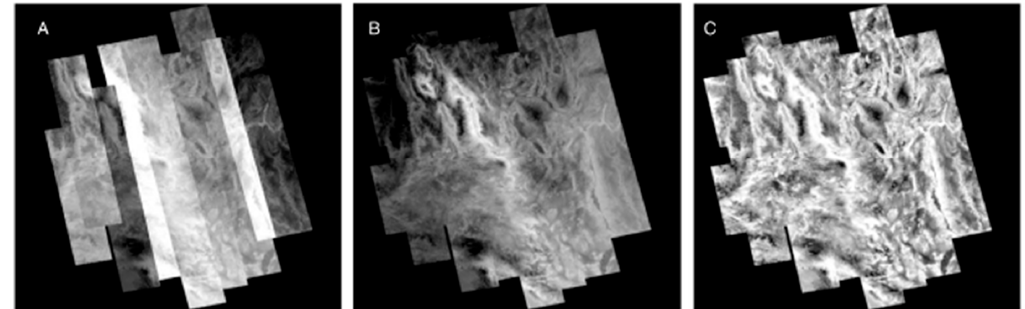
Figure 4. Mosaic steps used in this analysis shown using the nighttime scenes. ( A ) LST temperature orbit tracks are mosaicked without any manipulation of the emissivity-separated temperature, and displayed in relative temperature. ( B ) Each orbit track is adjusted and blended with adjacent tracks to produce a seamless temperature mosaic. ( C ) The seamless mosaic is stretched with a correction filter matched to MODIS LST to produce an image with a consistent contrast across the region.